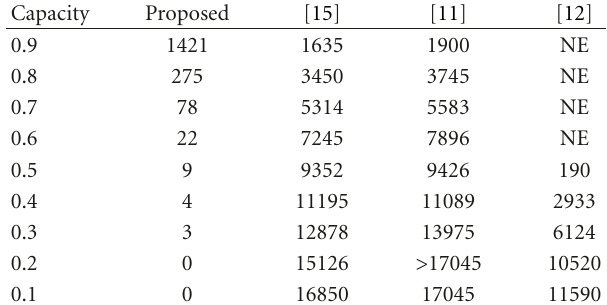
Table 2: Comparison of the number of auxiliary data between similar methods (NE: Not